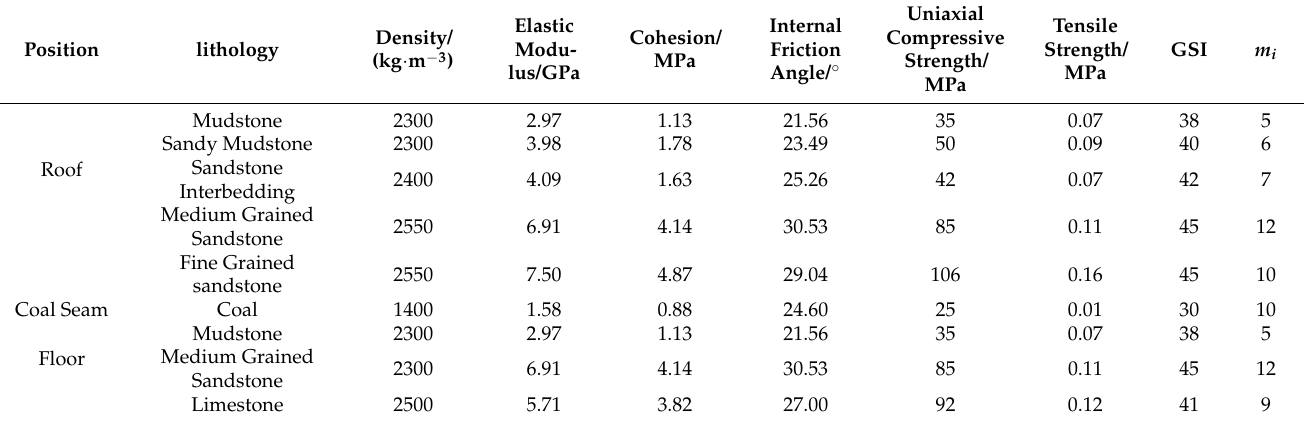
Table 1. Mechanical property parameter of rock and coal in numerical model.